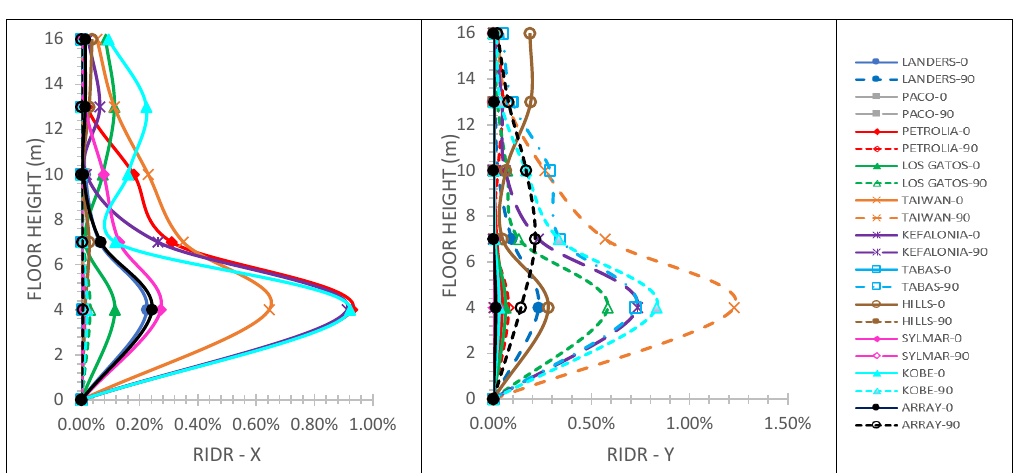
Figure 15. RIDR along X ( left ) and Y ( right ) horizontal directions of the five-story mixed building, considering the fixed connection of the steel structure to the r/c one.